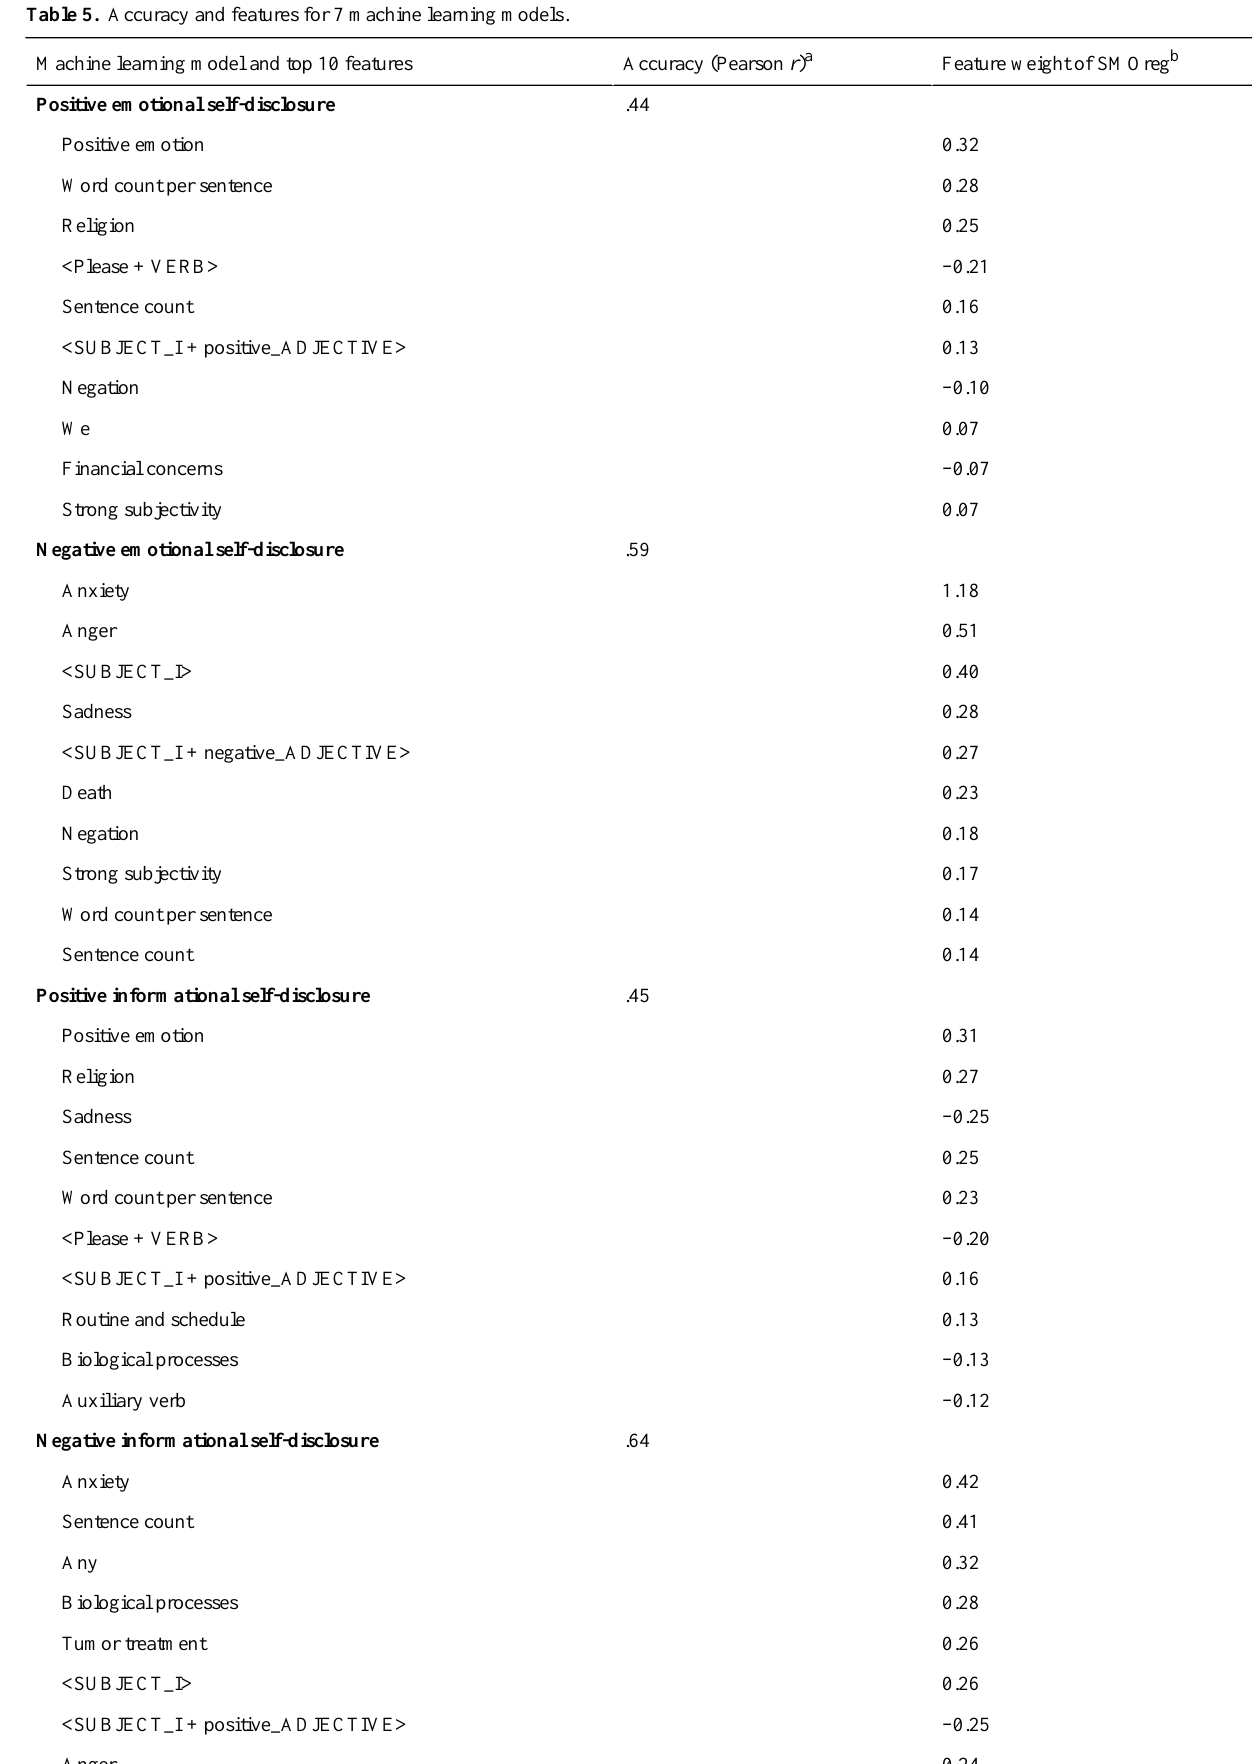
Table 5. Accuracy and features for 7 machine learning